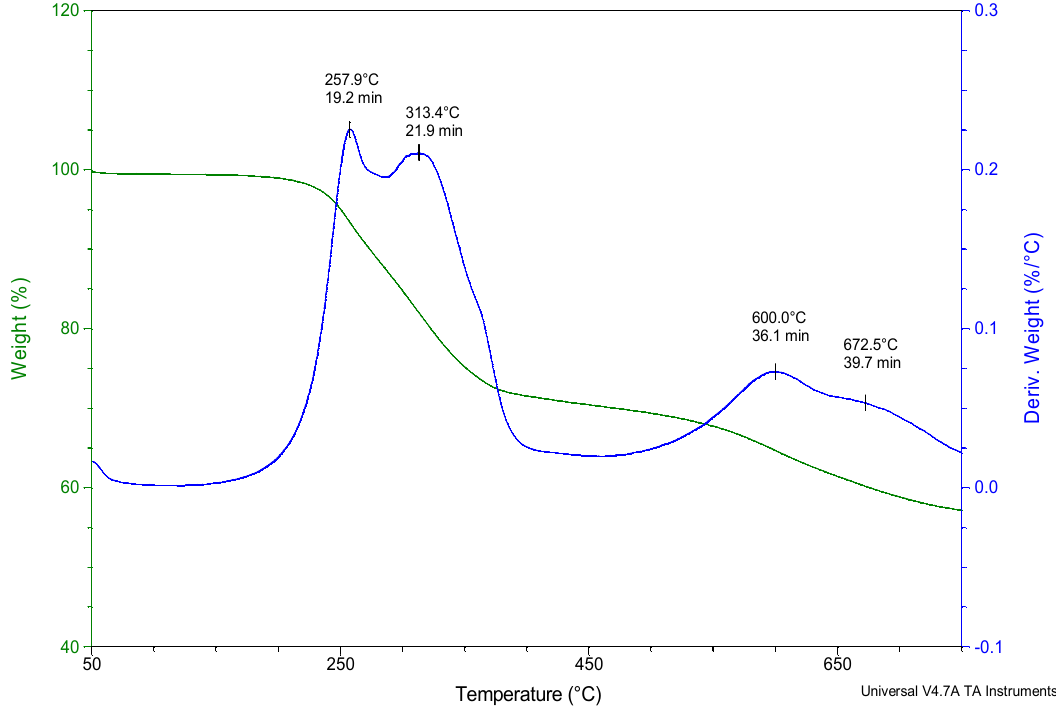
Figure 3. TG and DTG curves of C15A clay with marked FTIR analysis points.